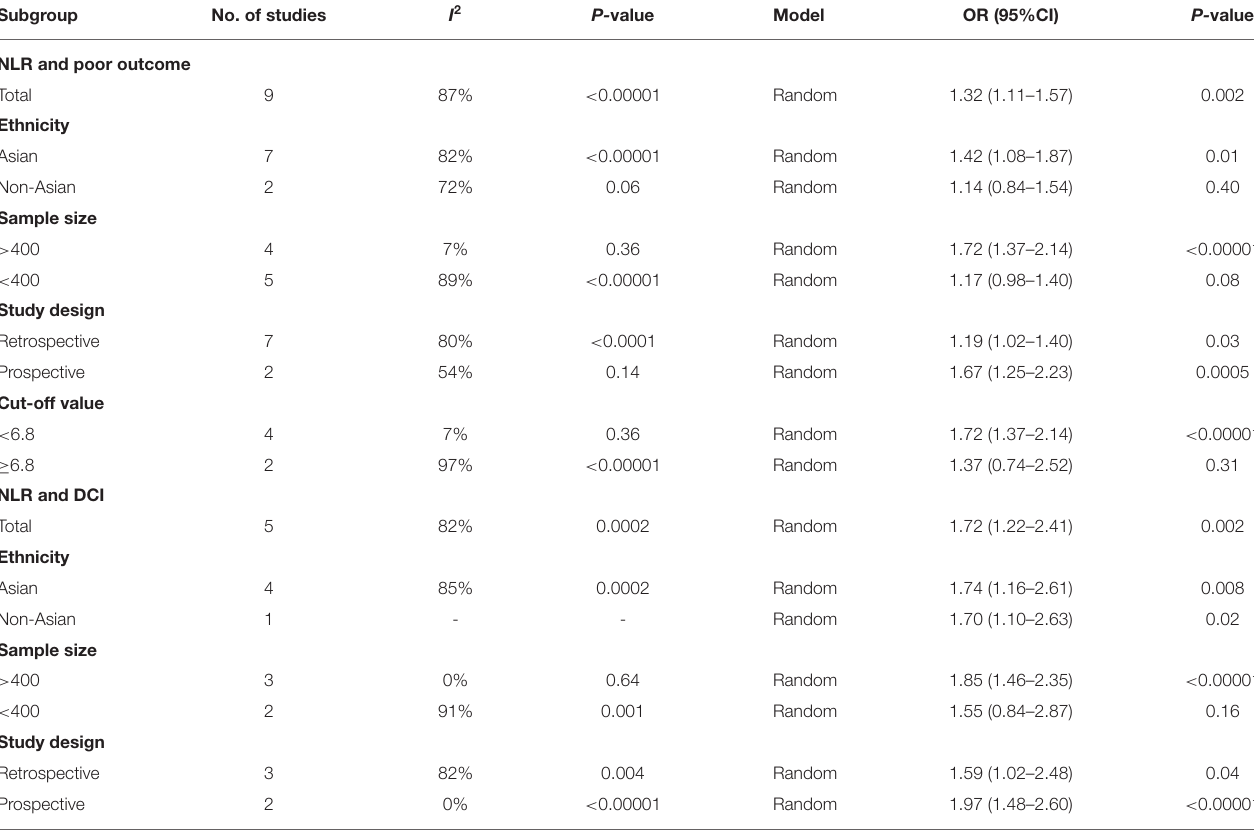
TABLE 2 | Subgroup analysis of the association of NLR with poor outcome and DCI.